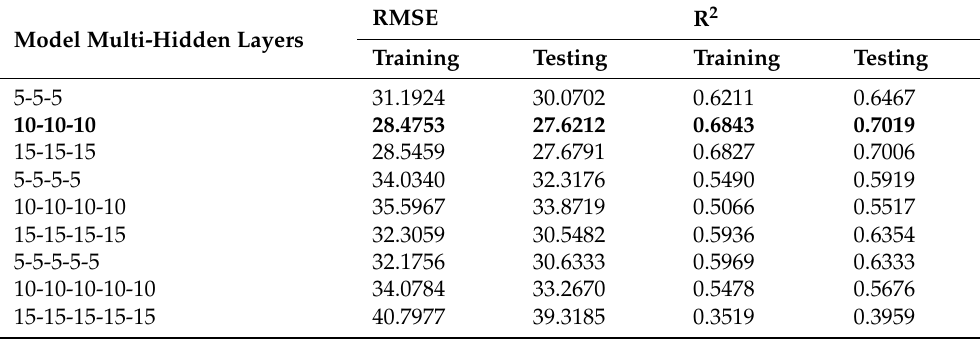
Table 3. Performance evaluation of DELM models with various numbers of hidden layers. Model Multi-Hidden